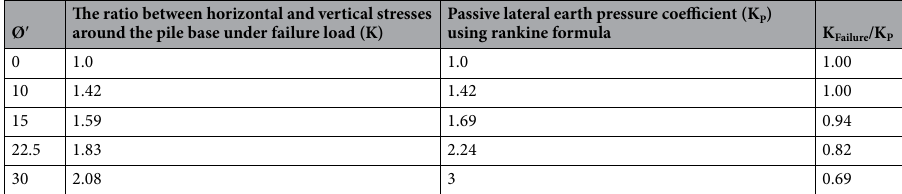
Passive lateral earth pressure coefficient (K P ) using rankine